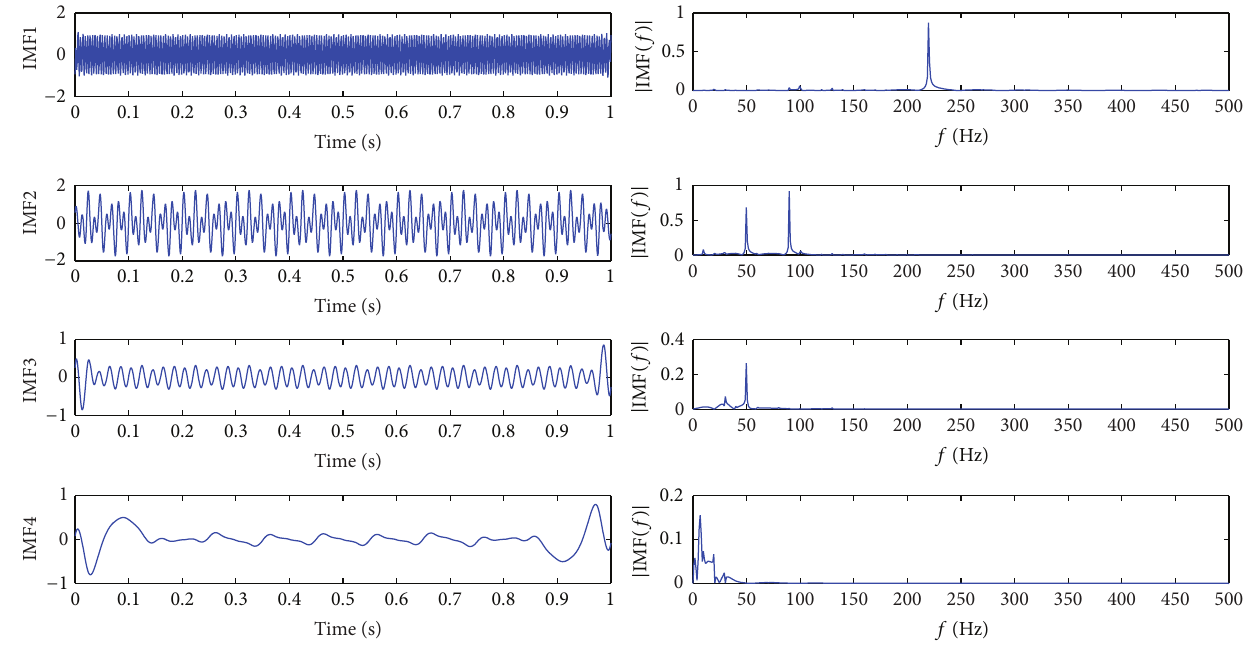
Figure 3: EMD effect and Hilbert spectrum of